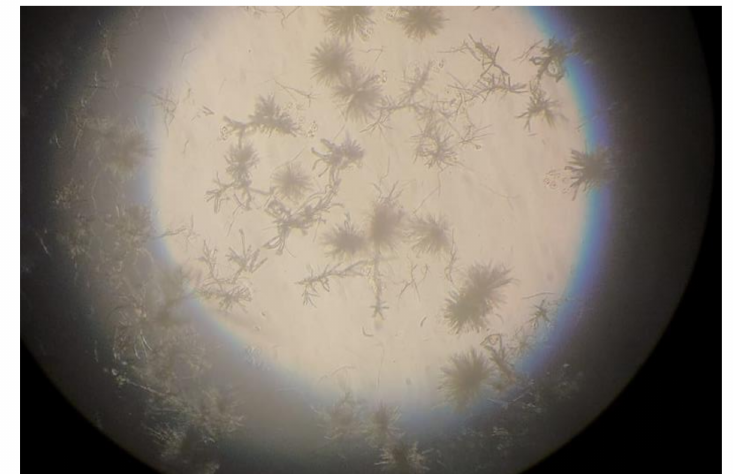
Figure 3. Macro-crystals formed by the free BBB4 released in the medium (173.4 µ M after 4 h, 239.9 µ M after 12 h, and 254 µ M after 24 h) from BBB4-G4K NPs at 15 µ M, responsible for the cell